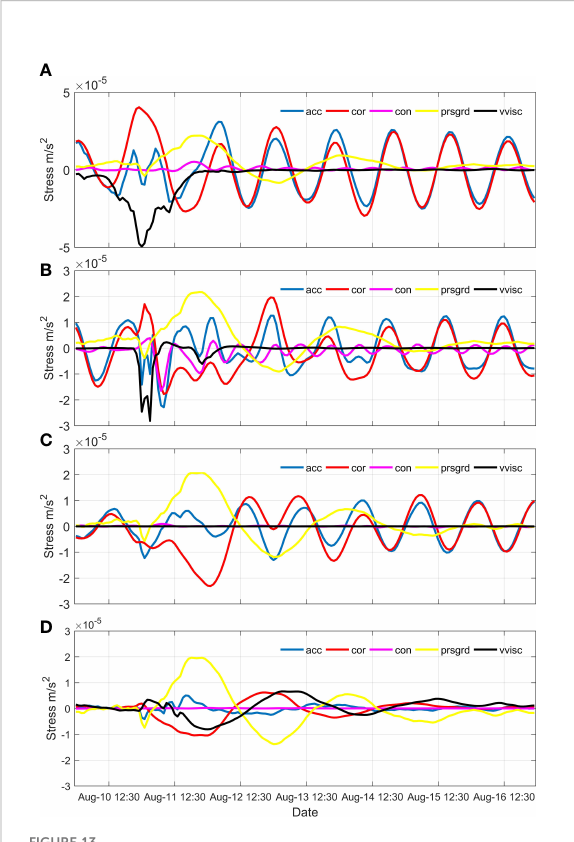
FIGURE 13 Diagnostic analysis in the different layers at the mooring site. (A) Surface layer. (B) Thermocline. (C) Lower mixing layer. (D) Bottom boundary layer. The blue, red, magenta, yellow, and black lines represent the term of acceleration, the Coriolis force, convection, pressure gradient force, and viscosity term,